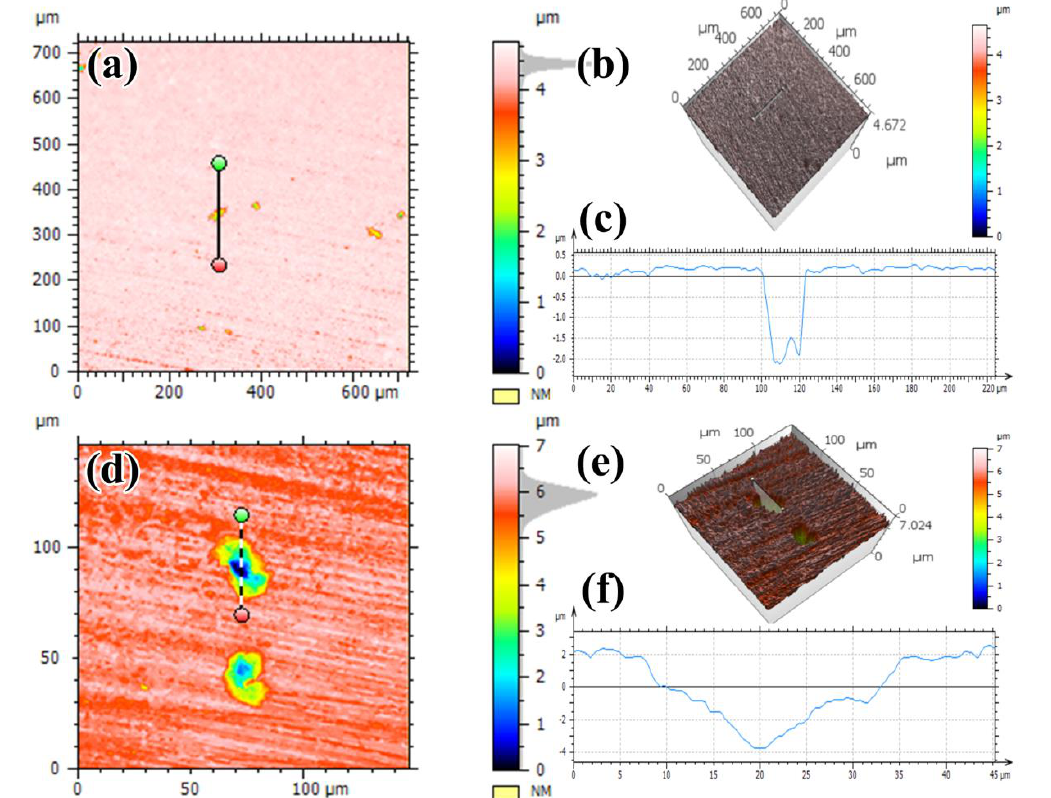
Figure 6. Maximum pit depth measured on specimen in the abiotic ( a – c ) and inoculated solutions ( d – f ) after 14 days.